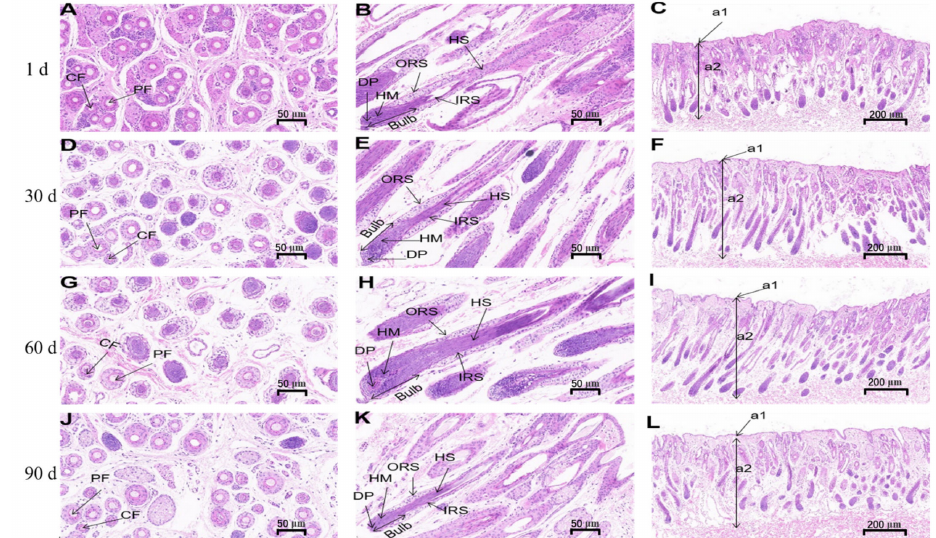
Figure 2. HE staining of skins of Gansu Alpine Merino at various ages. ( A , D , G , J ) Longitudinal section (20 × ); PF: primary hair follicle and CF: secondary hair follicle. ( B , E , H , K ) Transverse section (20 × ); HS: hair shaft, ORS: outer root sheath, IRS: inner root sheath, Bulb: hair bulb, DP: dermal papilla, and HM: hair matrix. ( C , F , I , L ) Transverse section (6.6 × ); a1: epidermis and a2: dermis.